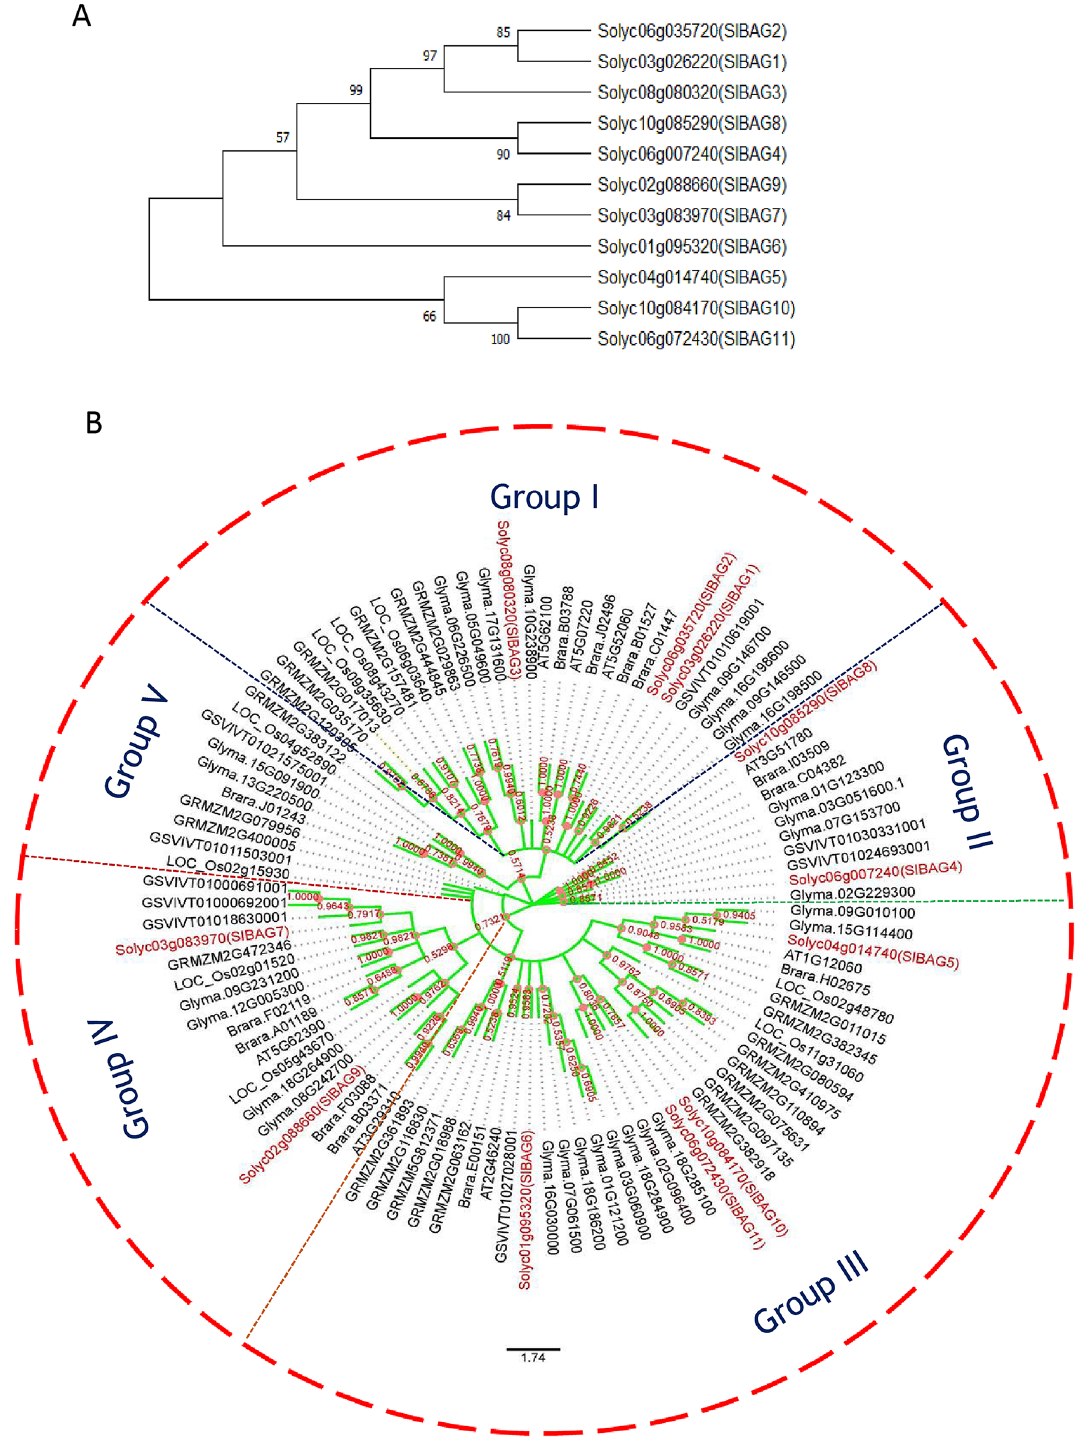
Figure 2. Phylogenetic analysis of SlBAG protein family of tomato and other plant species. ( A ) Evolutionary relationship among SlBAG proteins. ( B ) Phylogenetic tree of SlBAG proteins. The amino acid sequences of BAG family proteins from Solanum lycopersicon , Arabidopsis thaliana , Brassica rapa , Glycine max , Oryza sativa , Vitis vinifera and Zea mays were imported into the Molecular Evolutionary Genetics Analysis tool (MEGA X 10.1) (https:// www. megas oftwa re. net/) to make a phylogenetic tree by maximum-likelihood and bootstrap analysis was executed with 1000